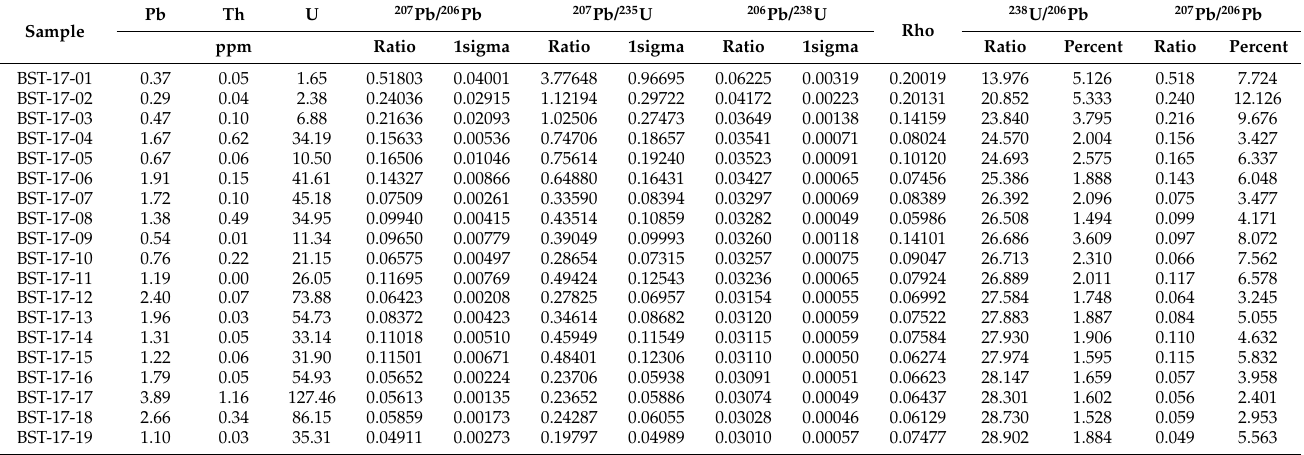
Table 1. LA-SF-ICP-MS U-Pb isotope data of the wolframite sample BST-17 from the Baishitouwa